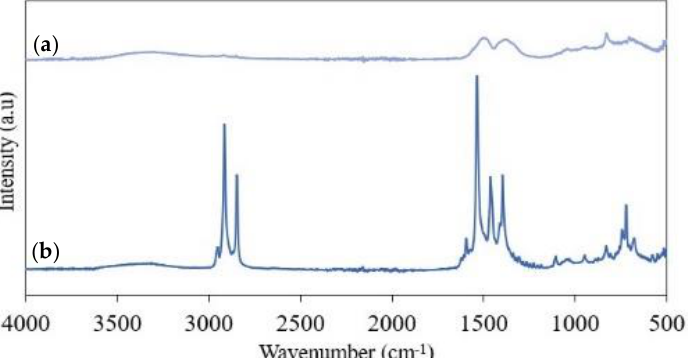
Figure 15. FTIR spectra of humidity samples after 1000 h: ( a ) uncoated surface and ( b ) hydrophobic surface.